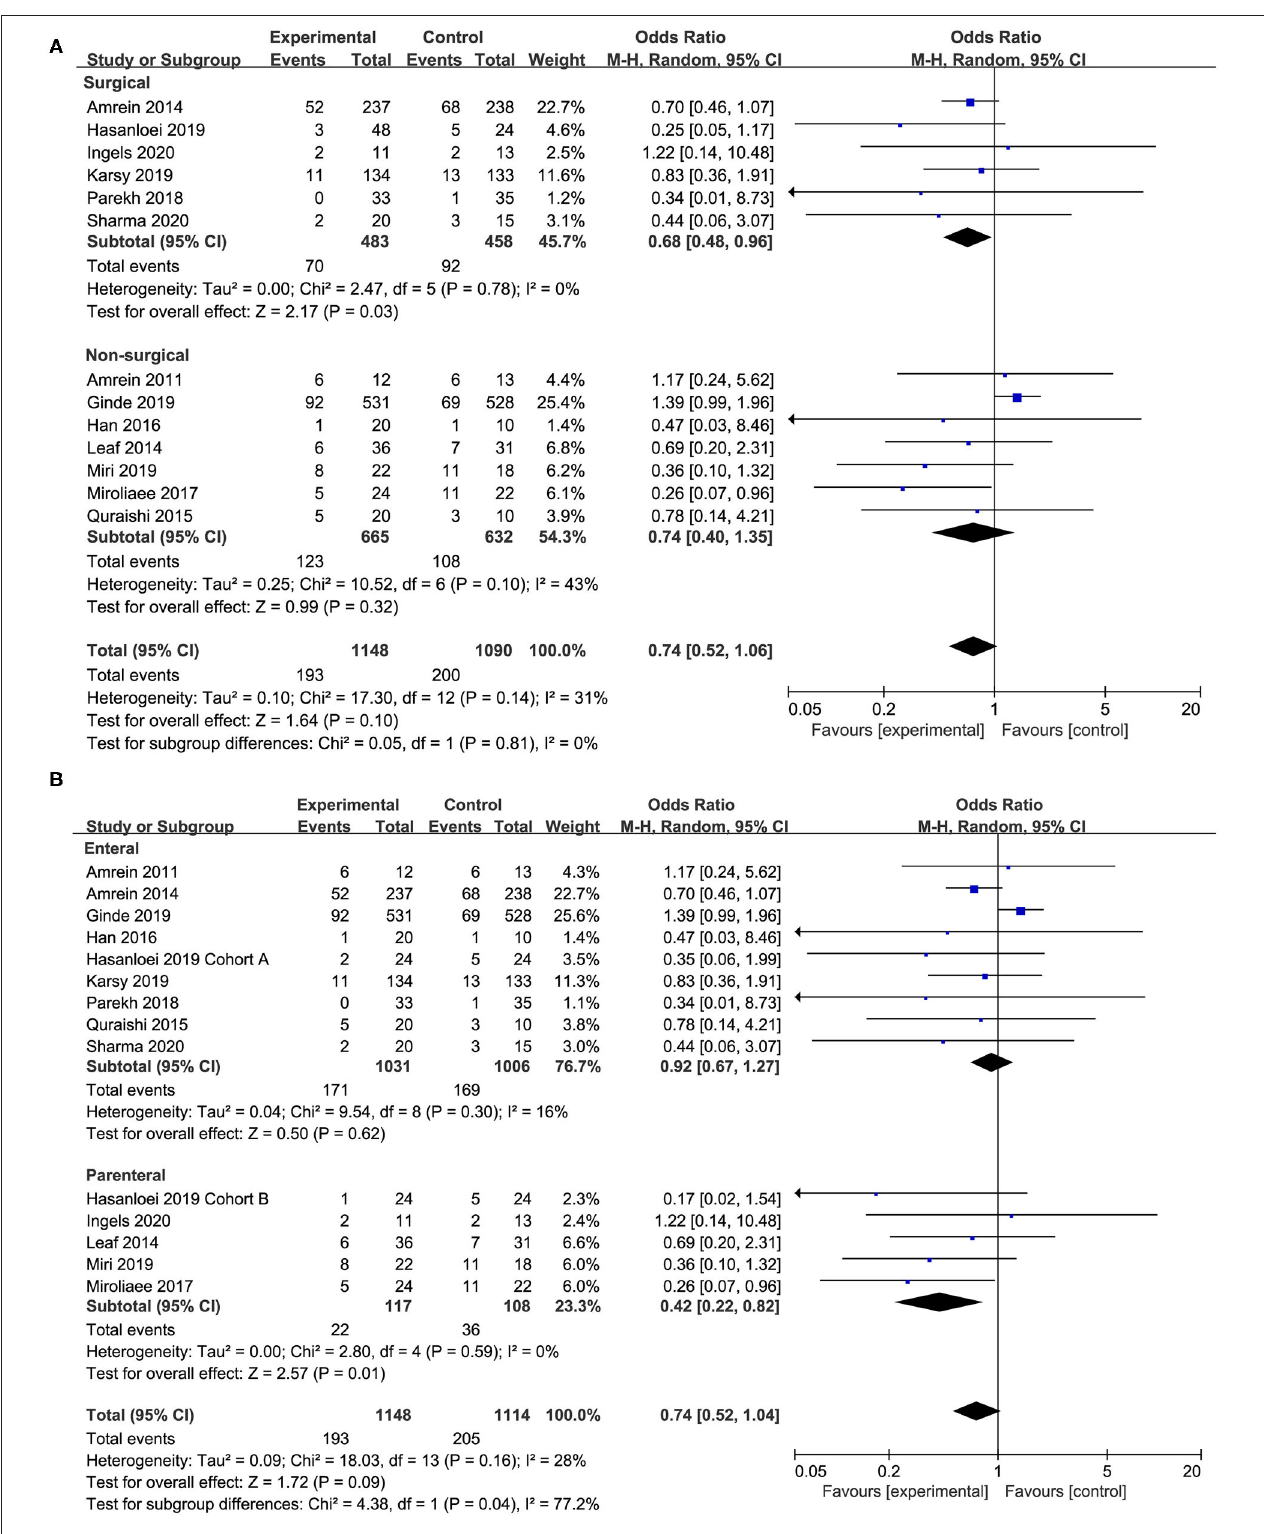
FIGURE 4 | Subgroup analysis for primary outcome. (A) Surgical vs. non-surgical patients; (B) enteral vs. parenteral route.